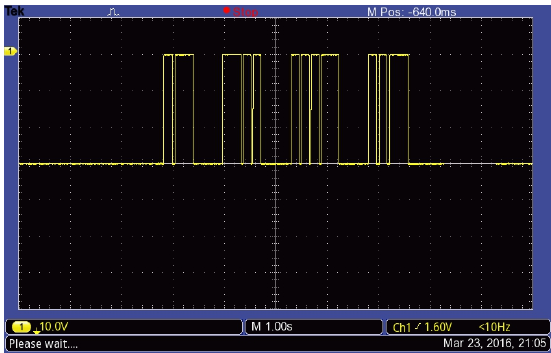
Figure 18. Voltage waveform obtained by interpreting optical Morse code “1832”.